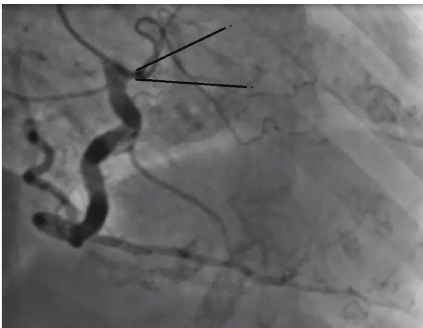
Figure 1: RCA in RAO. Nonselective engagement of the ostium of the RCA.